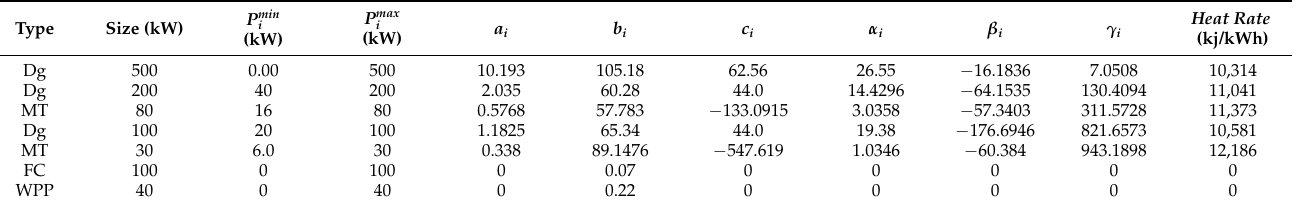
Table 3. Operational limits, fuel cost coefficient, emission coefficient, and heat rate data.